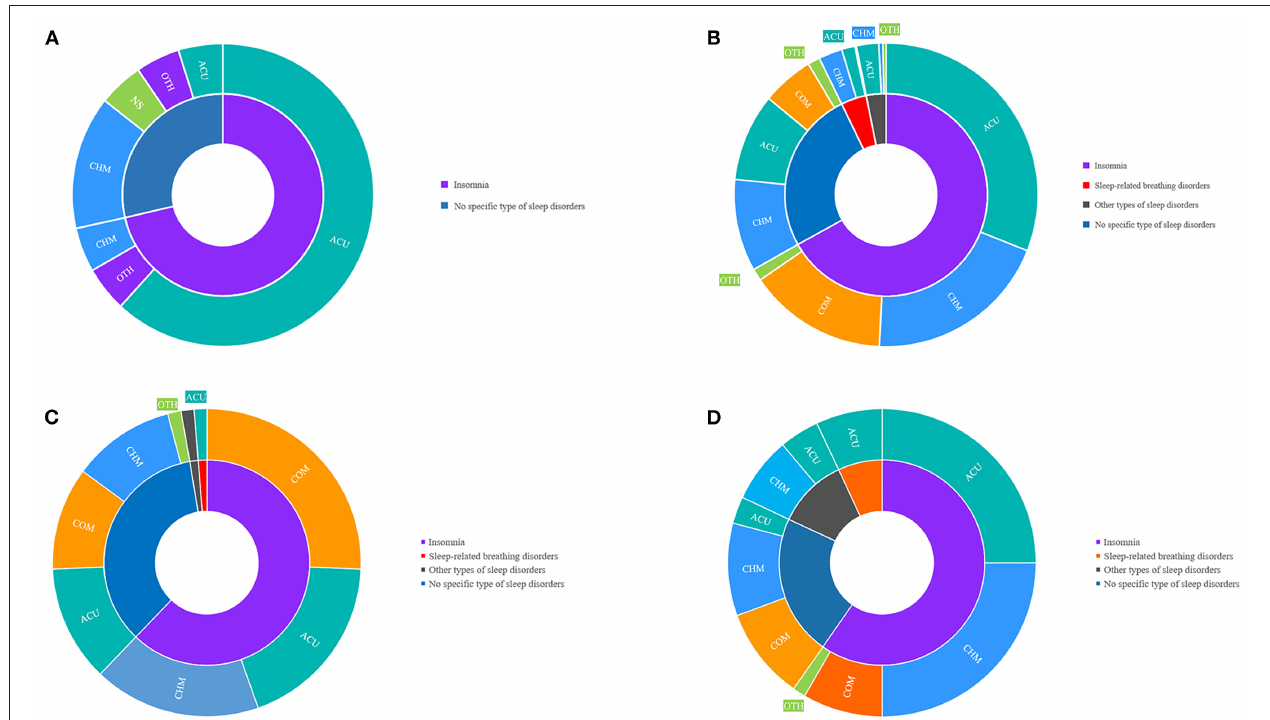
FIGURE 4 | Evidence body per study designs and types of sleep disorders and interventions. (A) the composition of systematic reviews in terms of the type of sleep disorder and traditional Chinese medicine treatment; (B) the composition of the randomized controlled trials in terms of the type of sleep disorder and traditional Chinese medicine treatment; (C) the composition of non-randomized controlled trials in terms of type of sleep disorder and traditional Chinese medicine treatment; (D) the composition of the observational studies in terms of the type of sleep disorder and traditional Chinese medicine treatment. ACU, acupuncture therapies; CHM, Chinese herbal medicine; COM, a combination of multiple Traditional Chinese Medicine methods; OTH, other Traditional Chinese Medicine